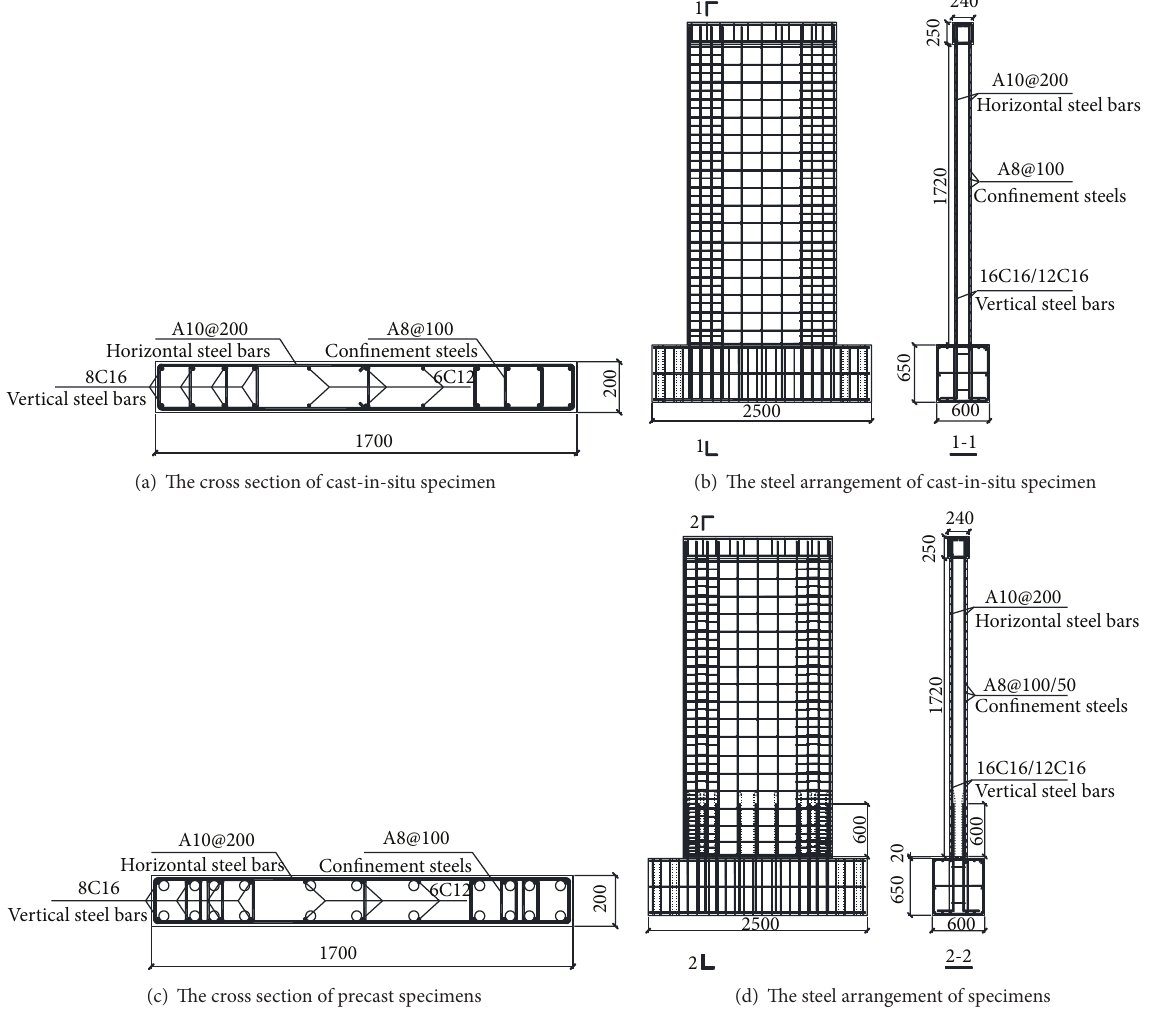
Figure 11: The specimen size and steel configuration